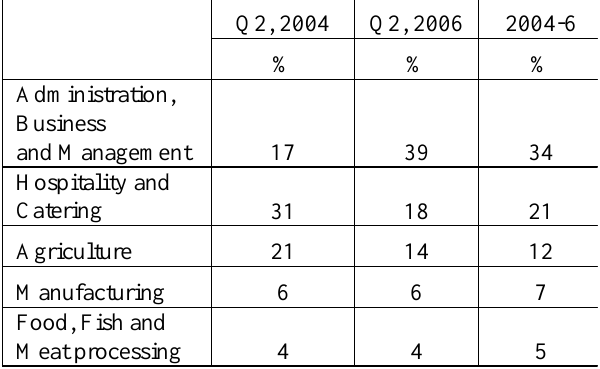
Table 3. Main Occupational groups of registered workers